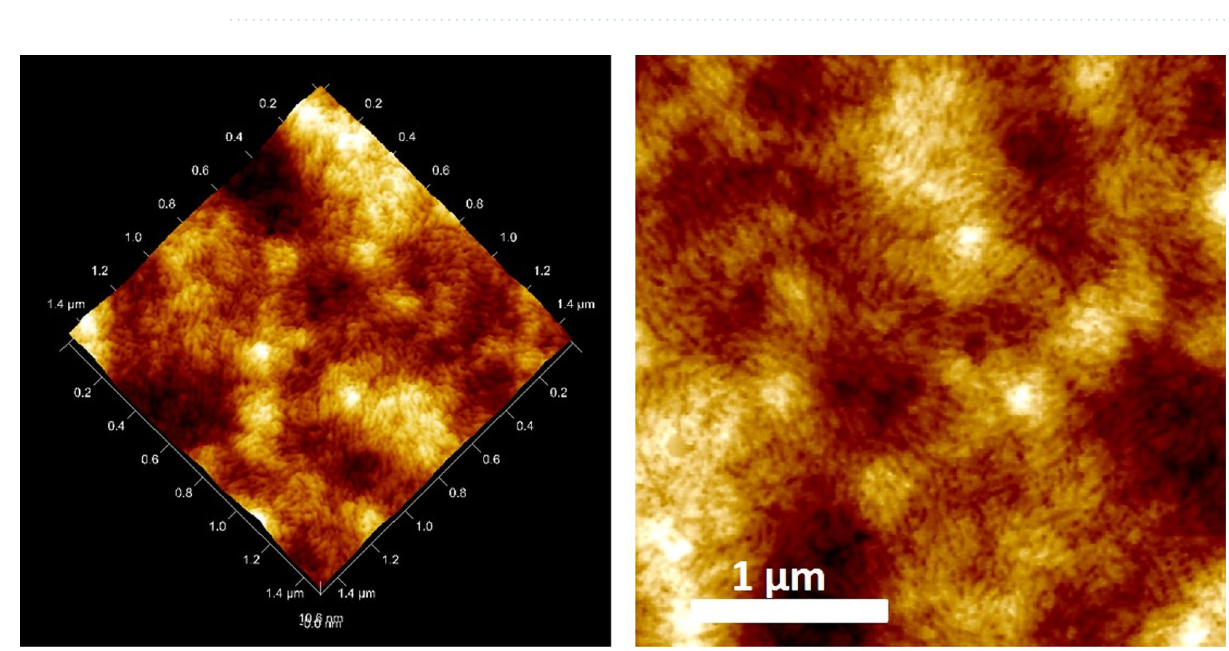
Figure 6. SEM and AFM images of ( a , d ) PEDOT-PSS; ( b , e ) PEDOT-SWNTs (10:1); ( c , f ) ZnO/PEDOT- SWNTs + (0.1 M) HClO